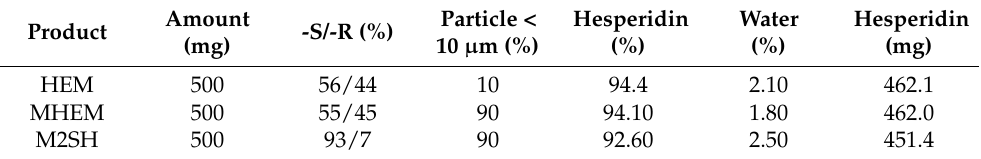
Table 1. Products of the clinical